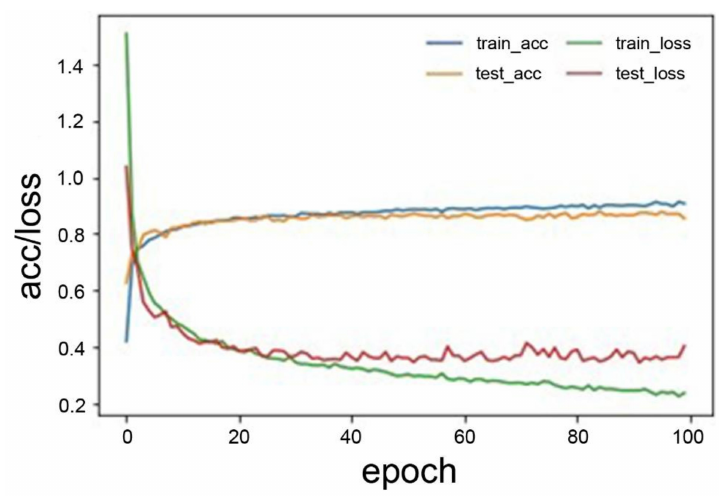
Figure 9. Convergence curves of accuracy and loss of CNN based on training and testing set.